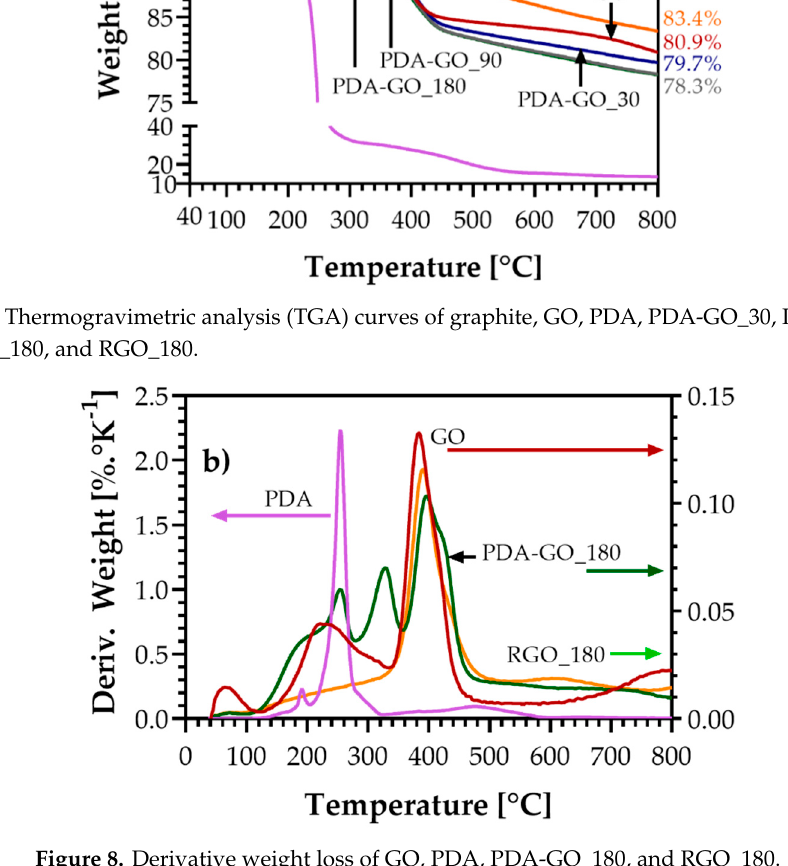
Figure 8. Derivative weight loss of GO, PDA, PDA-GO_180, and RGO_180.